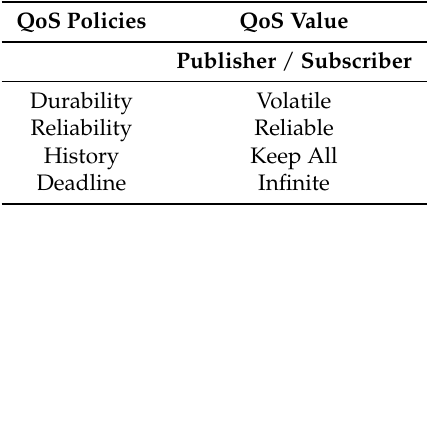
Figure 4. The Unmanned Aerial Vehicles (UAVs) structure based on Data Distribution Service (DDS) middleware. Table 2. Quality of services (QoS)